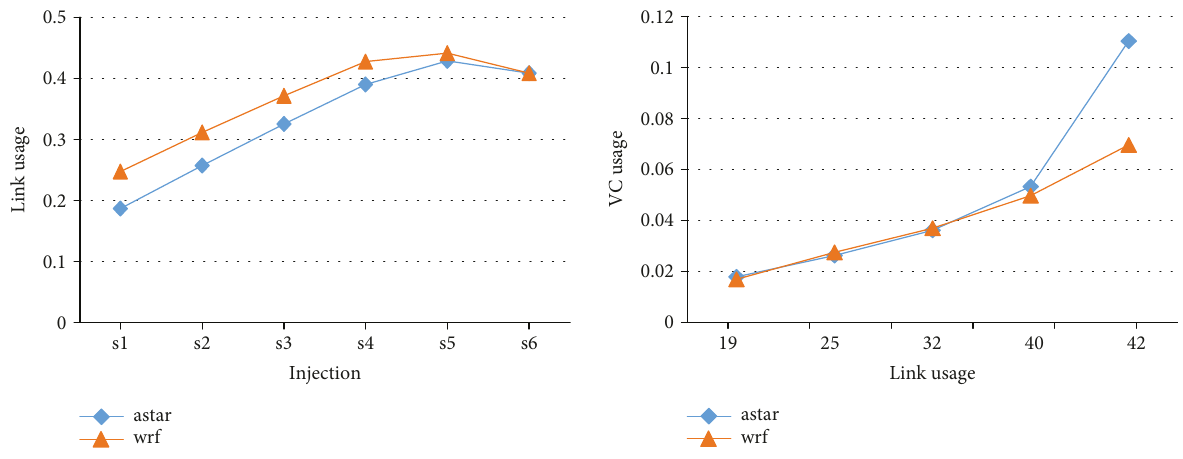
Figure 2: VC usage and link usage with simulated packet